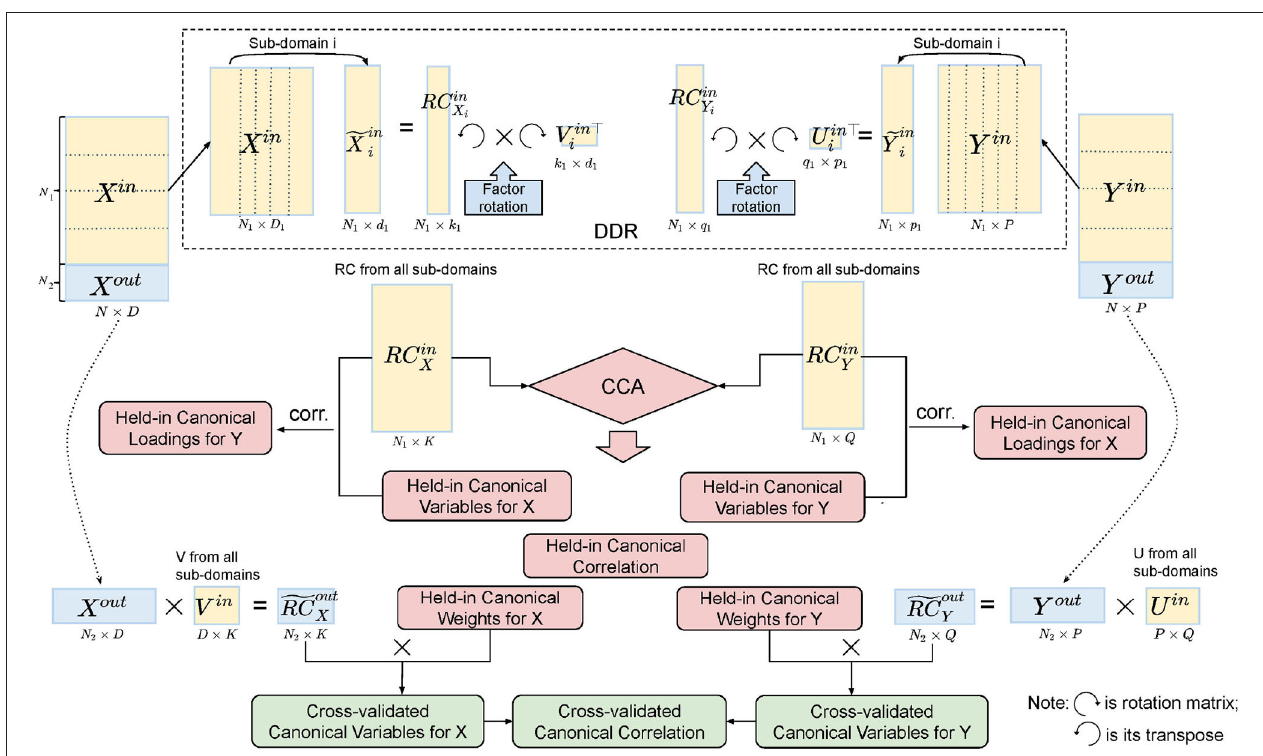
FIGURE 3 | Illustration of five-fold CV in the DDR CCA analysis. We apply DDR (dotted box on the top) to the training set after the split of the data. Within DDR, the principal loadings are rotated to construct the rotated components (RCs), and the RCs from the training set are fed into CCA. Cross-validated canonical variables and correlations are obtained by multiplying the training canonical weights with the RCs from the test